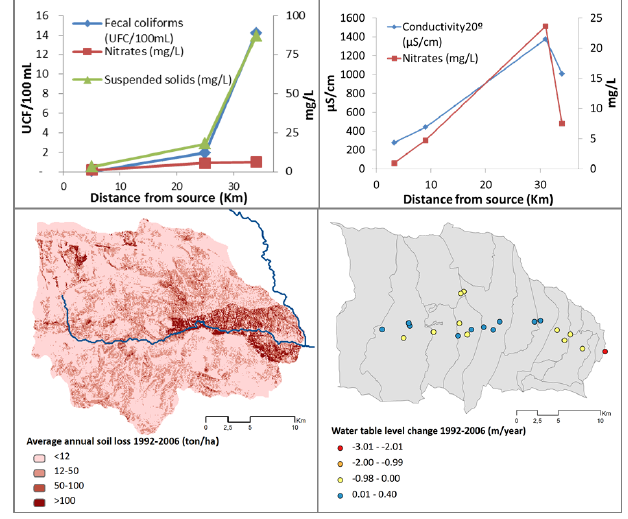
Fig. 9 . (a) Average annual water table change; (b) Average annual soil loss rates (c) Average groundwater water quality; (d) Average surface